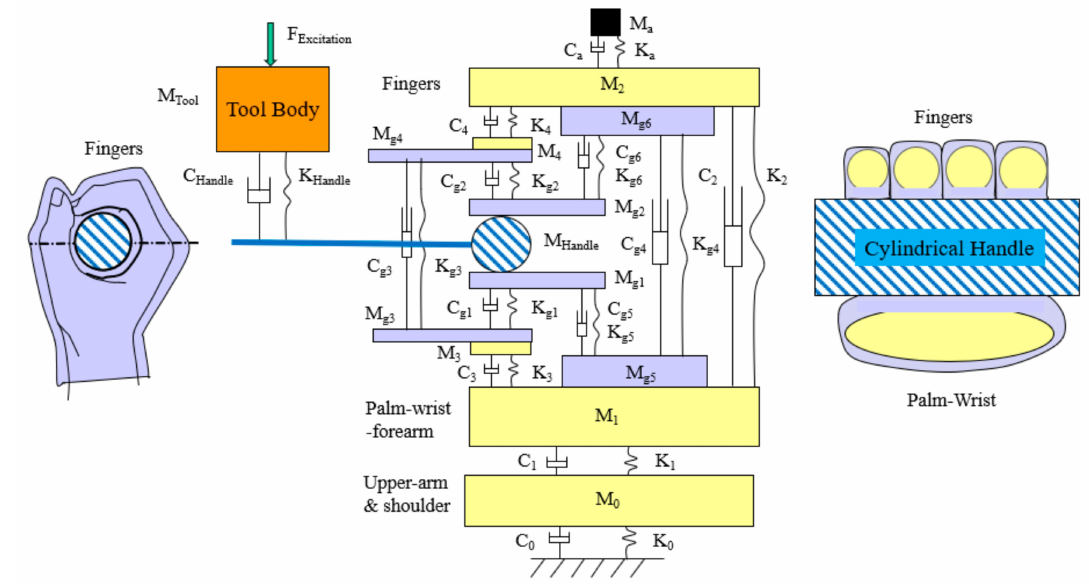
Figure 1. A lumped parameter model of the entire tool–handle–glove–hand–arm system used in this study and reported before